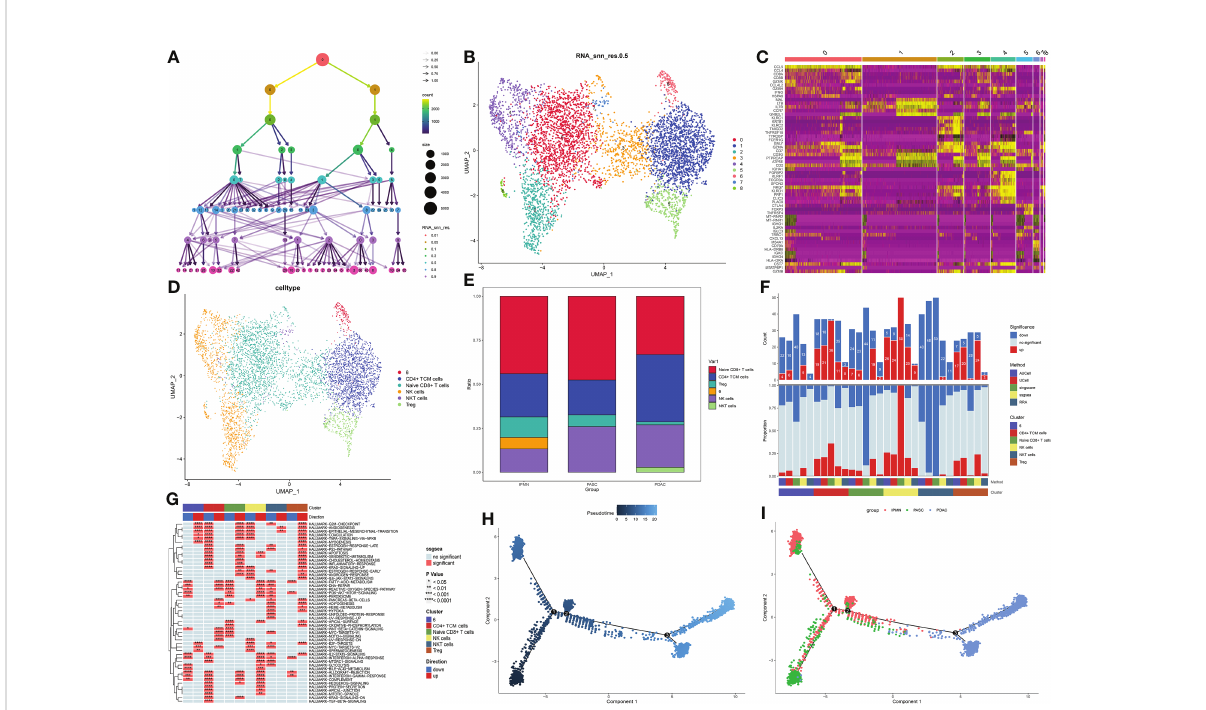
FIGURE 3 (A) Cluster tree of lymphocyte subgroup amounts at different resolution ratios. (B) UMAP cluster plot shows the divided subgroup before annotation. (C) Heatmap shows the signi fi cantly expressed genes in each cluster. (D) UMAP cluster plot shows the divided subgroup after annotation. (E) Bar graph of the proportion of each identi fi ed subgroup in each group. (F) Histogram showing the number of different enriched pathways in each identi fi ed subgroup. (G) GSVA plot showing the terms of different enriched pathways in each identi fi ed subgroup. (H, I) Pseudotime analysis of these annotated groups in ASPC, IPMN, and PDAC. UMAP, Uniform Manifold Approximation and Projection; GSVA, gene set variation analysis; ASPC, pancreatic adenosquamous carcinoma; IPMN, intraductal papillary mucinous neoplasm; PDAC, pancreatic ductal